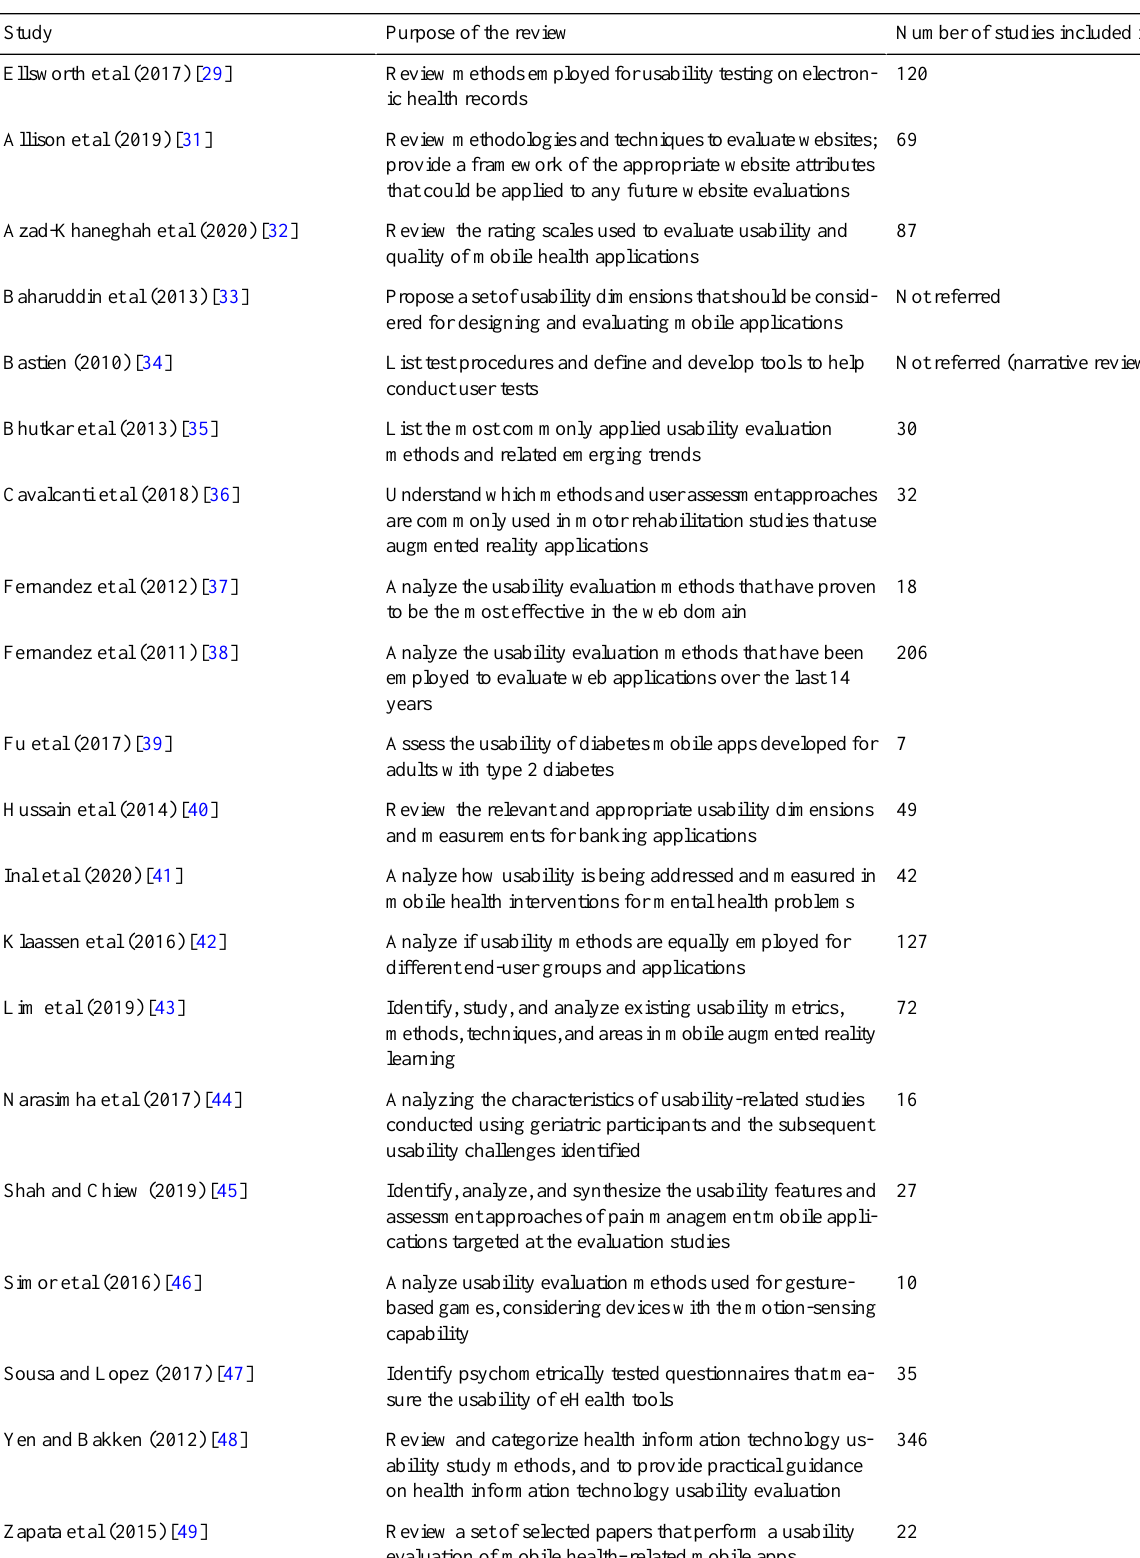
Table 2. General characteristics of included reviews.